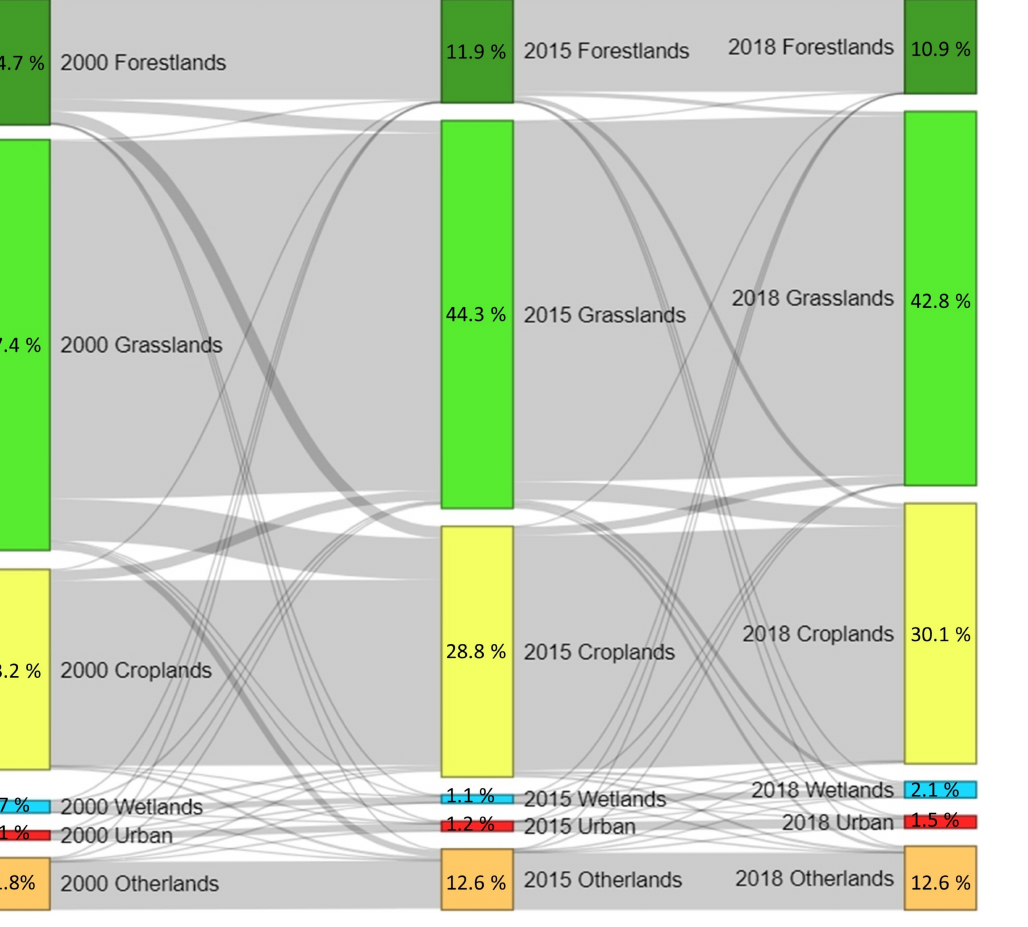
Figure 3. Sankey plot describing the land cover transitions between the years 2000, 2015 and 2018 using high-resolution land cover data. Bands represent the actual proportion of land that changed class over